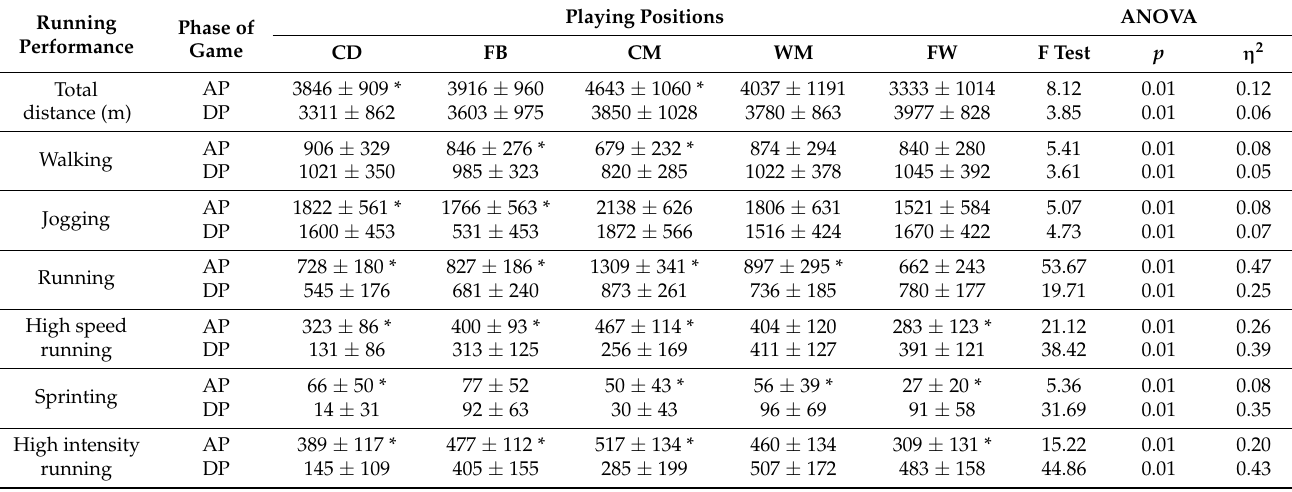
*—indicate significant differences ( p < 0.05) in RP between AP and DP of game determined by T -test for dependent sample; CD = Central defenders, FB = Fullbacks, CM = Central midfielders, WM = Wide midfielders, FW = Forwards; AP = attacking phase of game, DP = defensive phase of